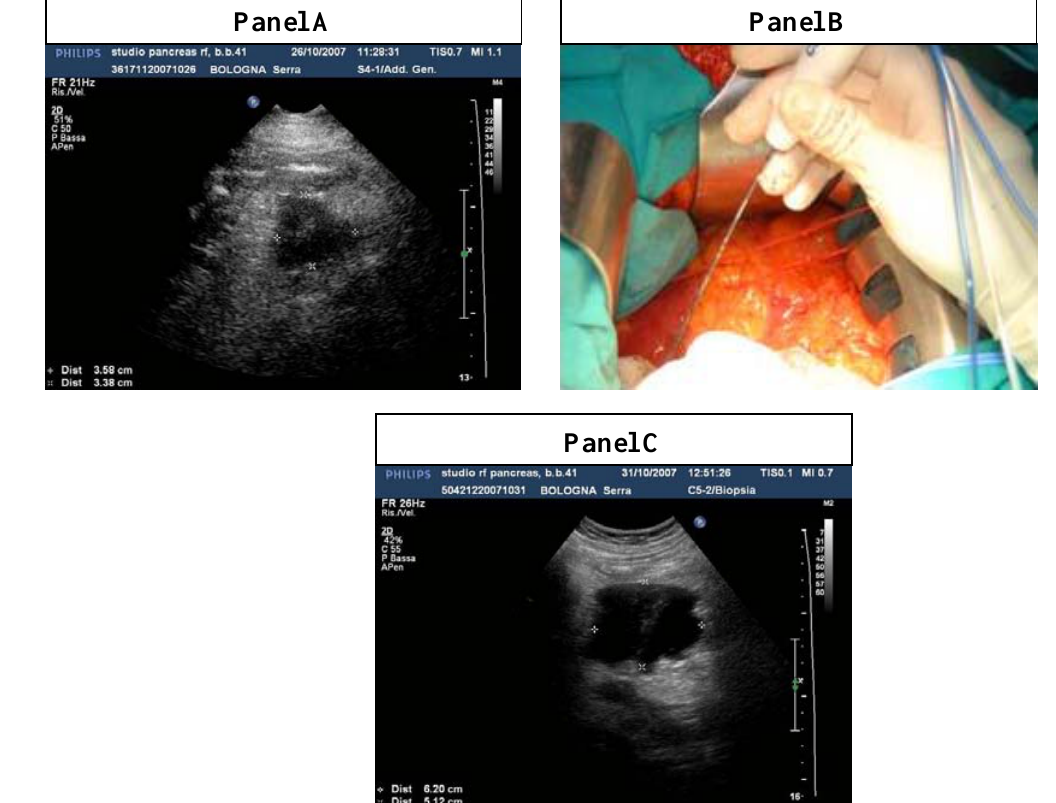
Panel A Panel B